Question: Does the figure show an increasing or a decreasing trend?
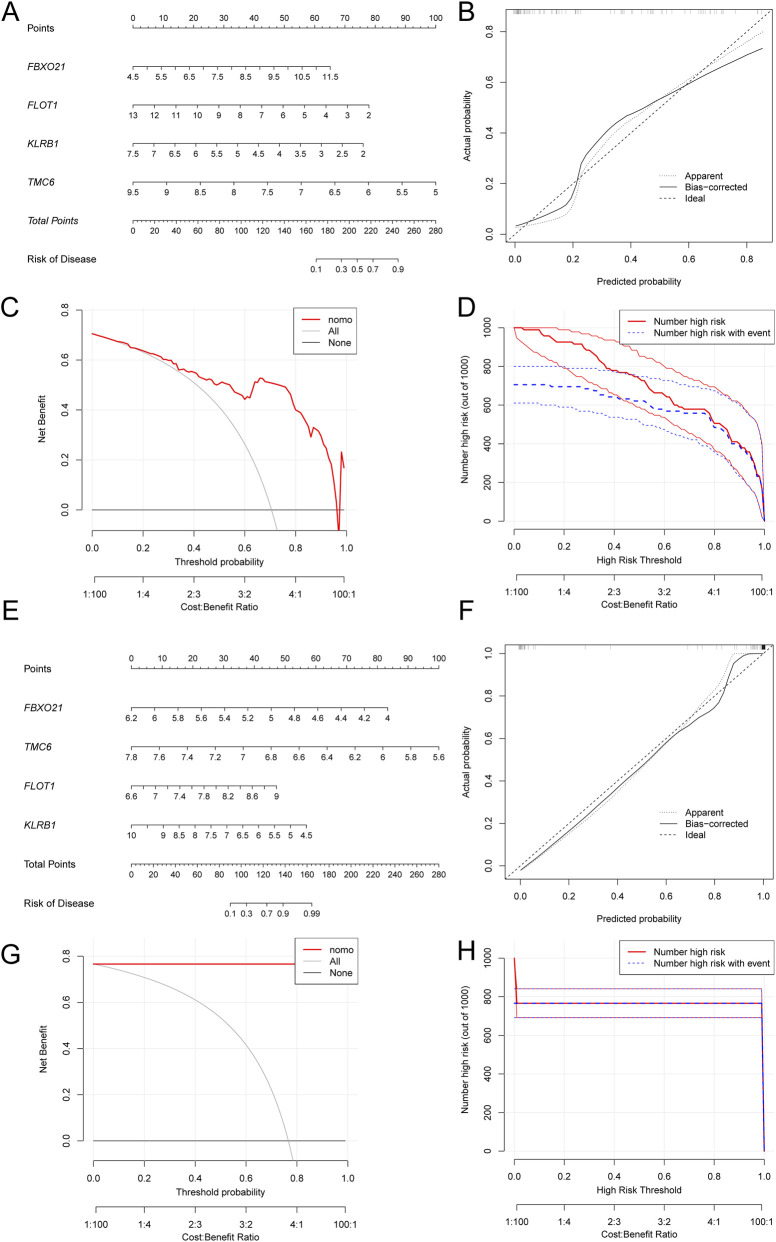
Answer: increasing